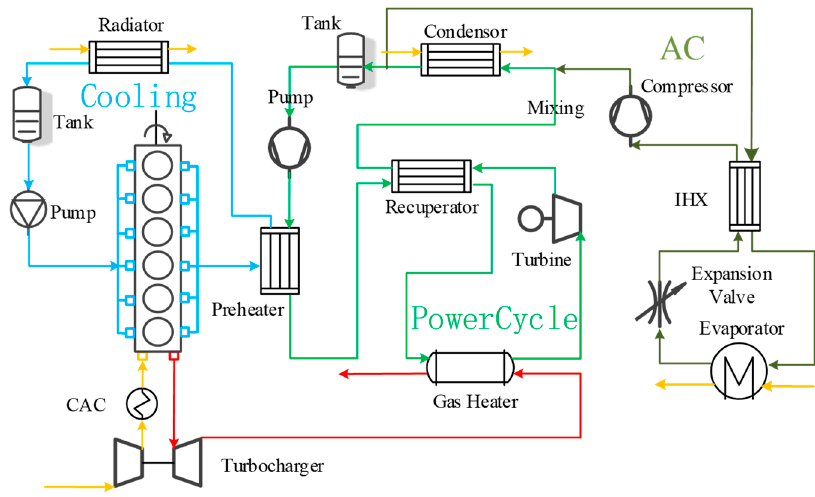
Figure 1. Schematic diagram of the thermal management system.